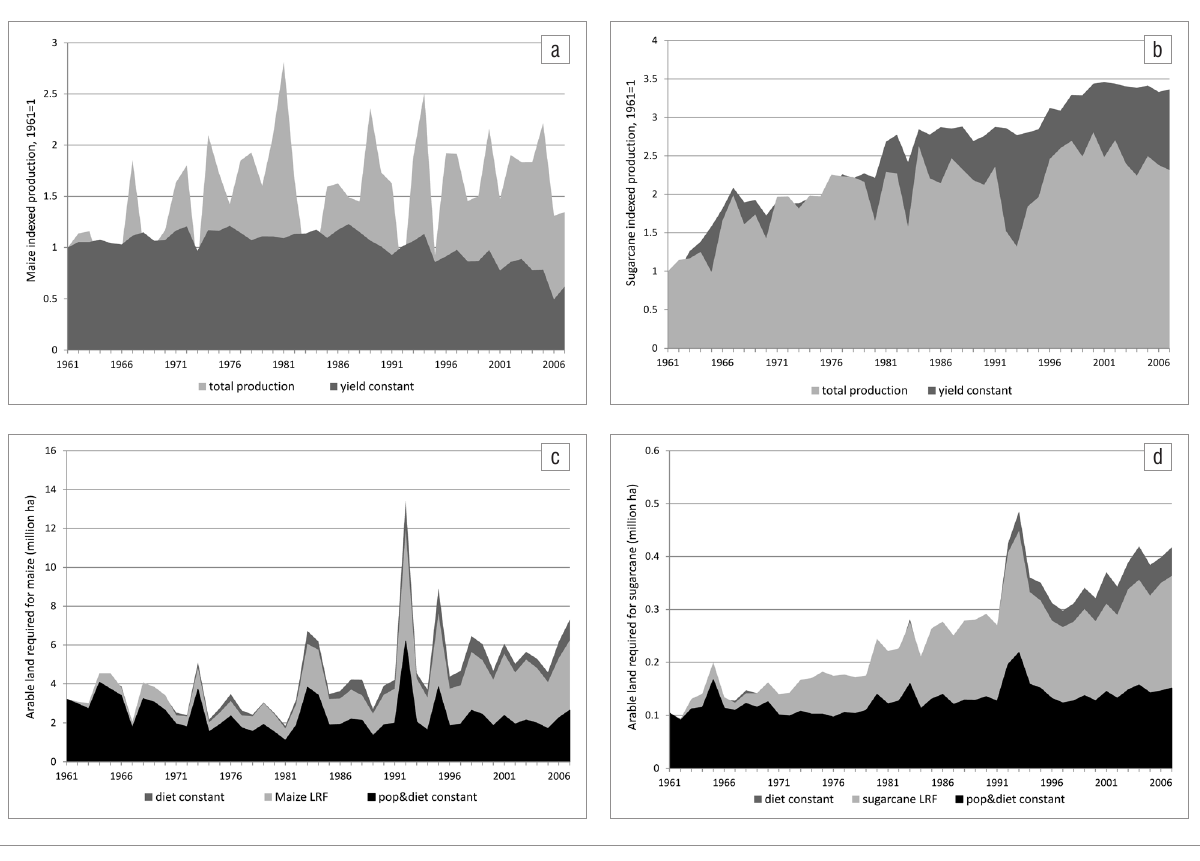
Figure 5: Development of indexed dry matter and the land requirements of maize and sugarcane in South Africa from 1961 to 2007: (a) indexed development of dry matter maize production (1961=1); (b) indexed development of dry matter sugarcane production (1961=1); (c) relevance of changes in yield, population and diet in land requirements for maize; and (d) relevance of changes in yield, population and diet in land requirements for